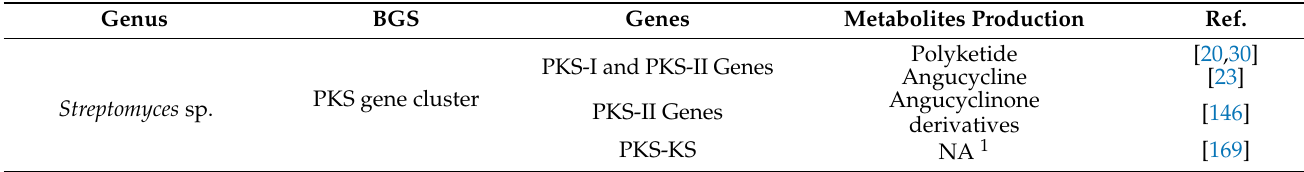
Table 8. Biosynthetic gene clusters identified in marine actinobacteria reported in this study. Genus BGS Genes Metabolites Production Ref.